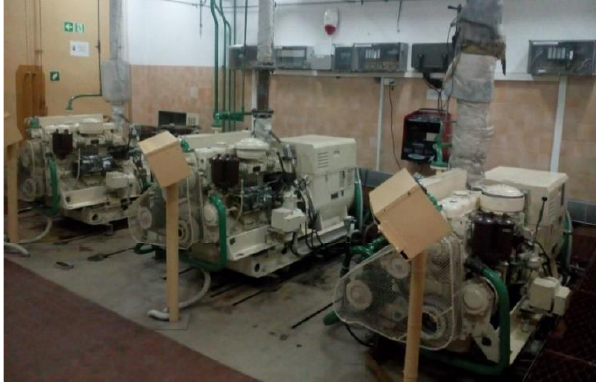
Fig. 5. Research object in the Laboratory for the Operation of Electric Ship Equipment